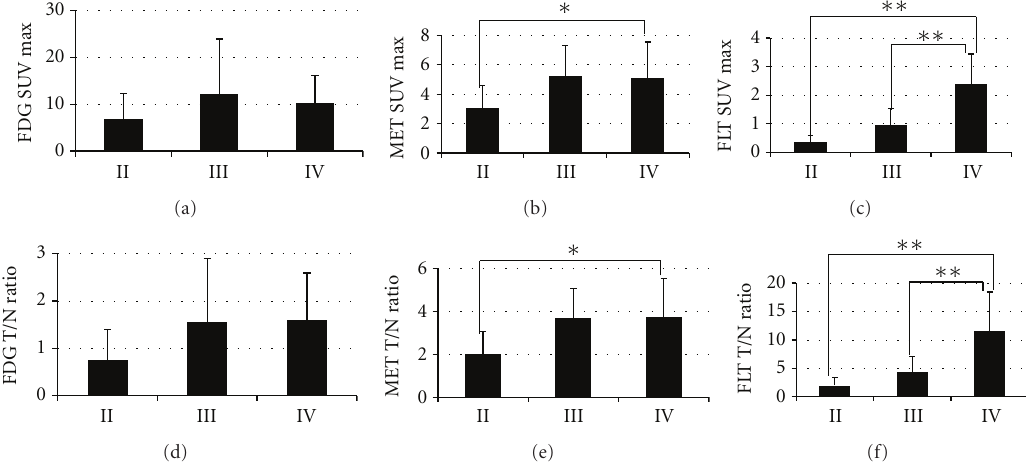
Figure 1: Comparison of SUV max and T / N ratios for FDG (a), (d) MET (b), (e) and FLT (c), (f) in gliomas by WHO grade. There were no significant di ff erences in FDG-PET scan. The di ff erences in MET SUV max and T / N ratio were statistically significant between grades II and IV gliomas ( ∗ P < 0 . 05), but not significant between grade II and III gliomas. The di ff erences in FLT SUV max and T / N ratio were statistically significant between grade III and IV gliomas, grade II and grade IV ones ( ∗∗ P < 0 . 01). (Figure 2(b)) or MET T / N ratio ( r = 0 . 39, P < 0 . 01) (Figure 2(e)), as well as FLT SUV max ( r = 0 . 73, P < 0 . 001) (Figure 2(c)) or FLT T / N ratio ( r = 0 . 63, P < 0 .